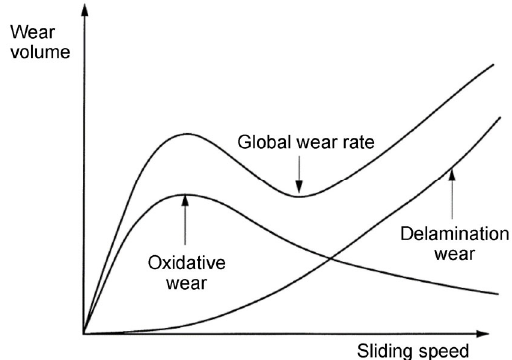
Fig. 25 Qualitative representation of variation in wear volume with increment in sliding speed (representing the domains of the occurring wear mechanisms). Reproduced with permission from Ref. [25]. Copyright Elsevier, 1997.